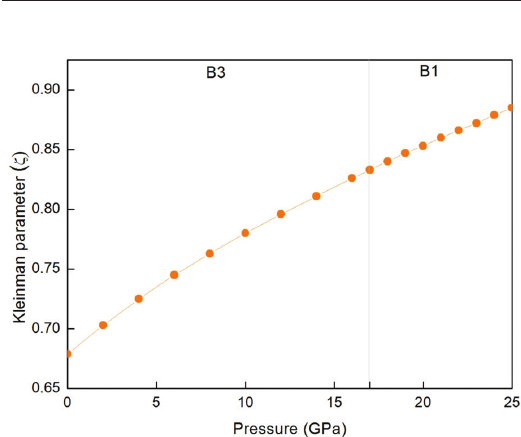
Figure 10. Degree of anisotropy for GaAs between 0 GPa and 25 GPa.